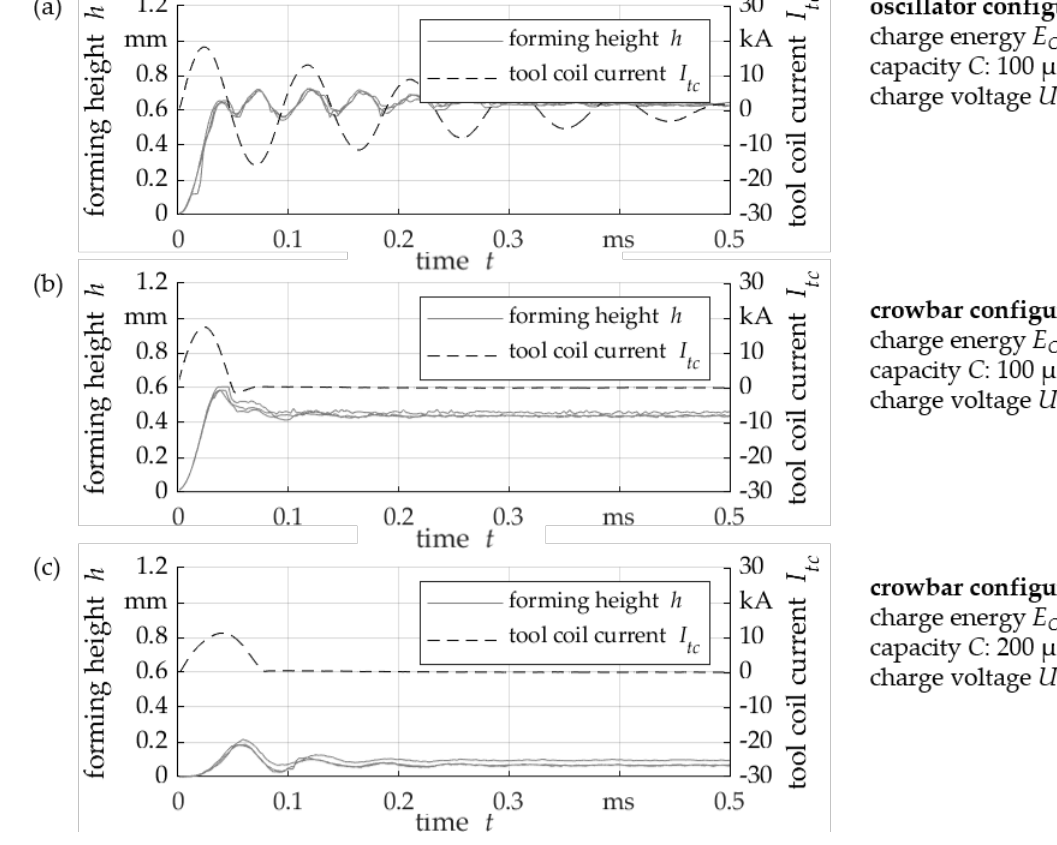
Figure 5. Forming height h in time domain for different configurations and different charge energy values: ( a ) oscillator configuration ( E C = 450 J), ( b ) crowbar configuration ( E C = 450 J), ( c ) crowbar configuration ( E C = 225 J).